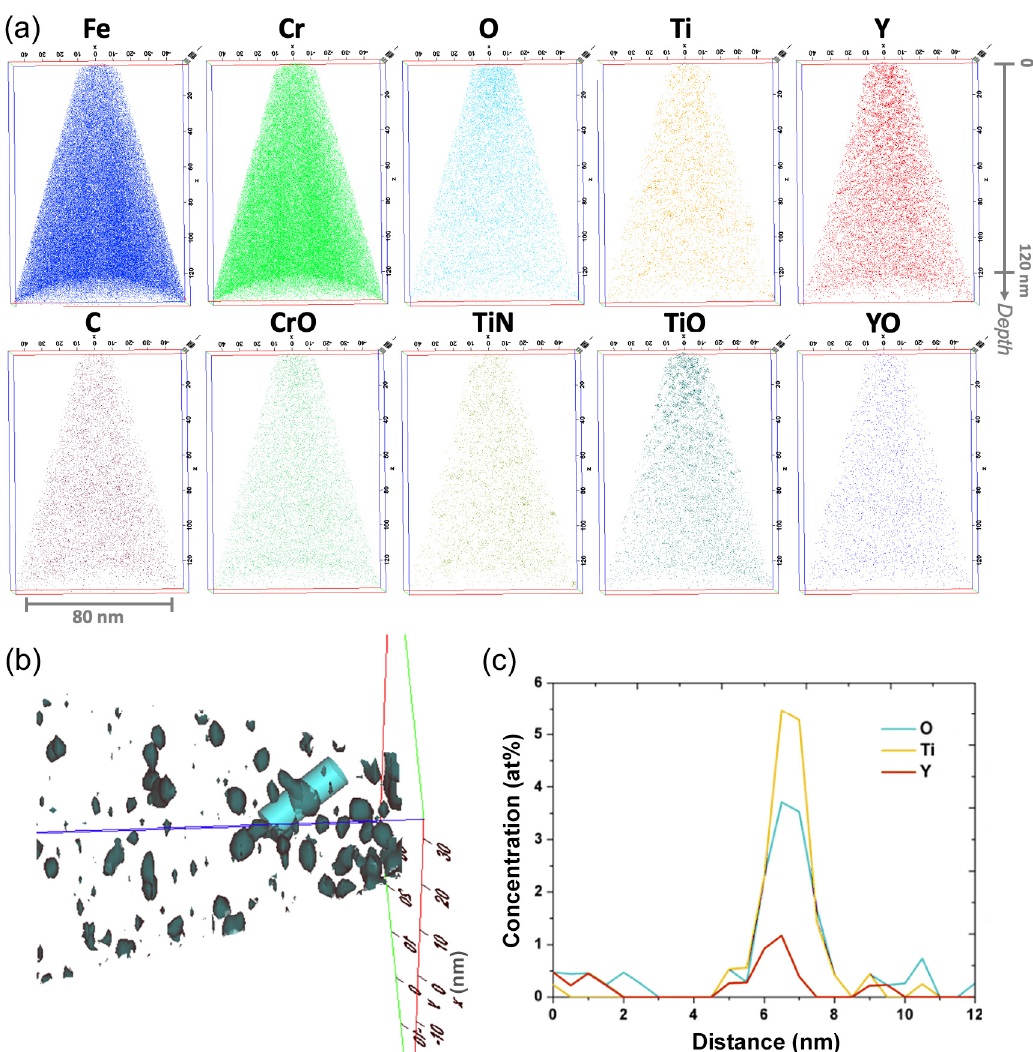
Figure 7. ( a ) Three-dimensional reconstructions of APT tips extracted from an FeCr specimen implanted with Y → Ti → O ions and annealed at 800 ◦ C for two hours, showing the distributions of the evaporated Fe, Cr, O, Ti, Y, and C elements, as well as CrO, TiN, TiO, and YO molecular ions. ( b ) Three-dimensional image of TiO clusters represented using an iso-concentration surface of 0.8% TiO. ( c ) Concentration profiles along a cylinder running through a cluster, as represented in ( b ). The cylinder is 12 nm long.